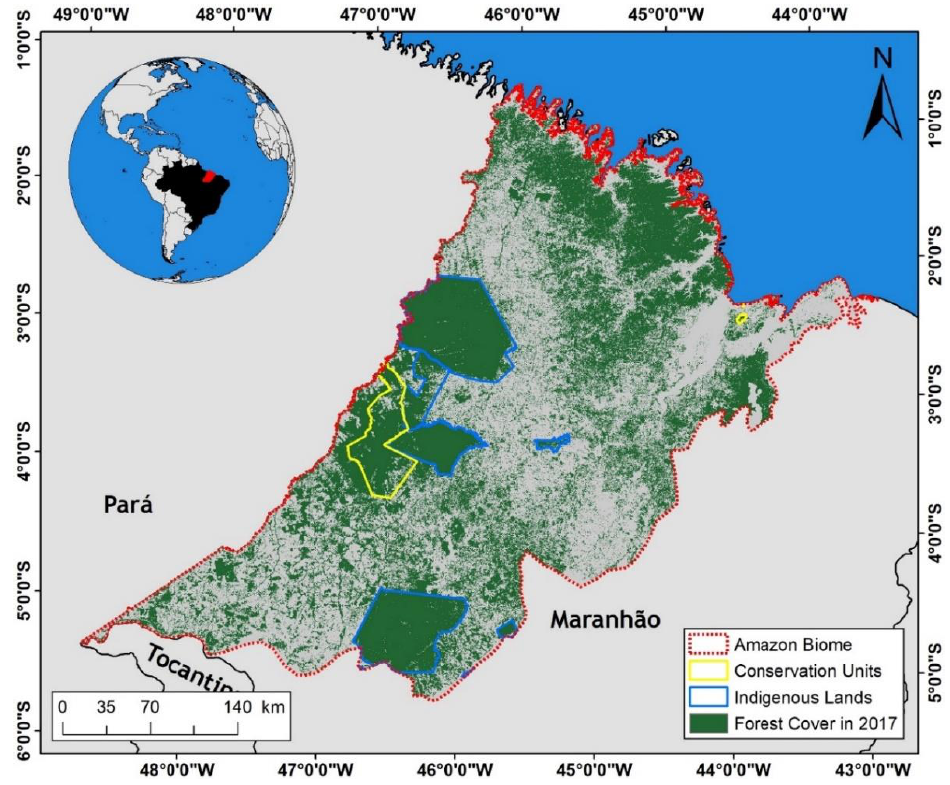
Figure 1. Map of the study area (the Amazon biome in Maranhão state). Forest cover from the MapBiomas project [41].